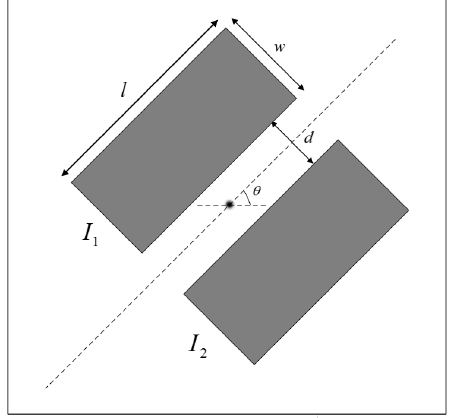
Figure 6. The processing window of Ratio Of Averages (ROA) at orientation pi /4.